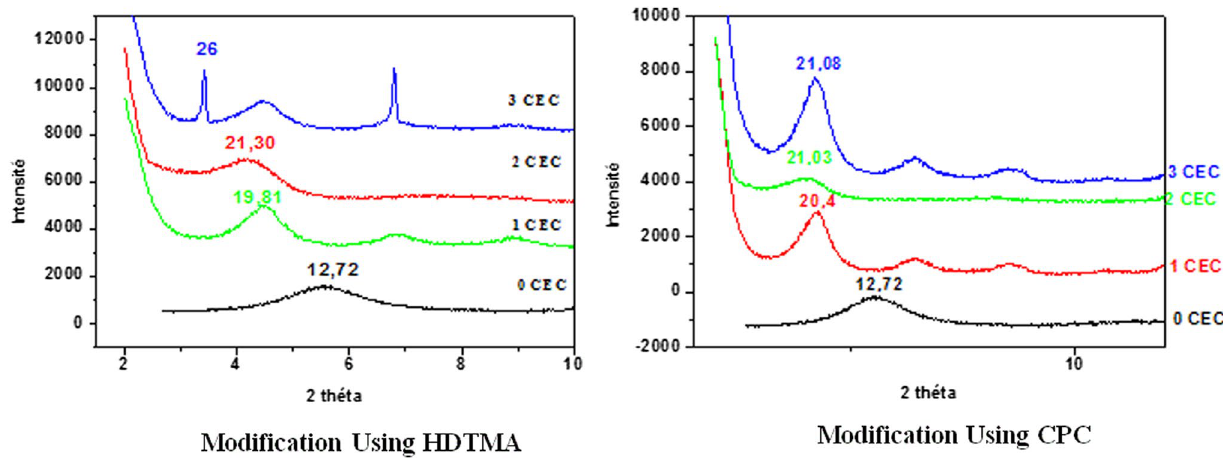
Fig. 2 X-ray diffractograms of purified clay (0 CEC) and organophilic clays by HDTMA and CPC (different concentrations 1, 2 and 3 CEC)